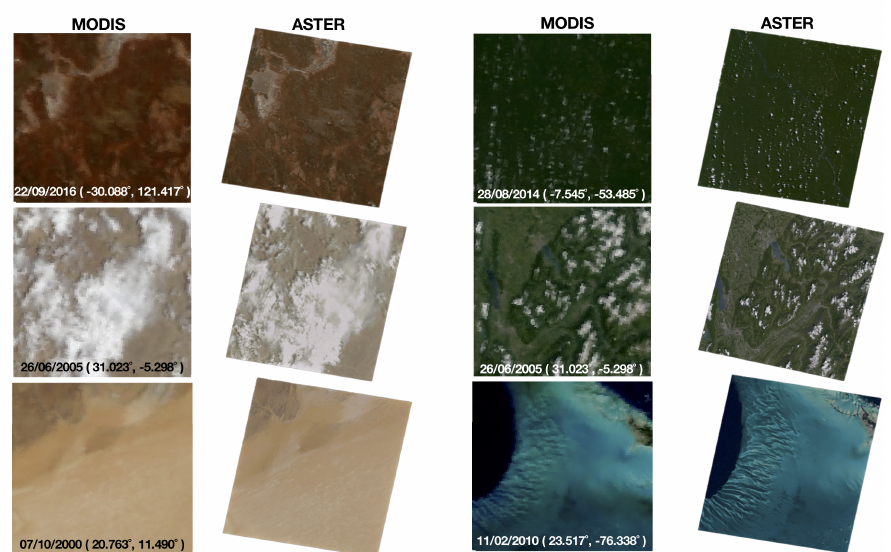
Figure 12. Comparison between the color rendering by MODIS on the left and ASTER (natural color simulated) on the right.